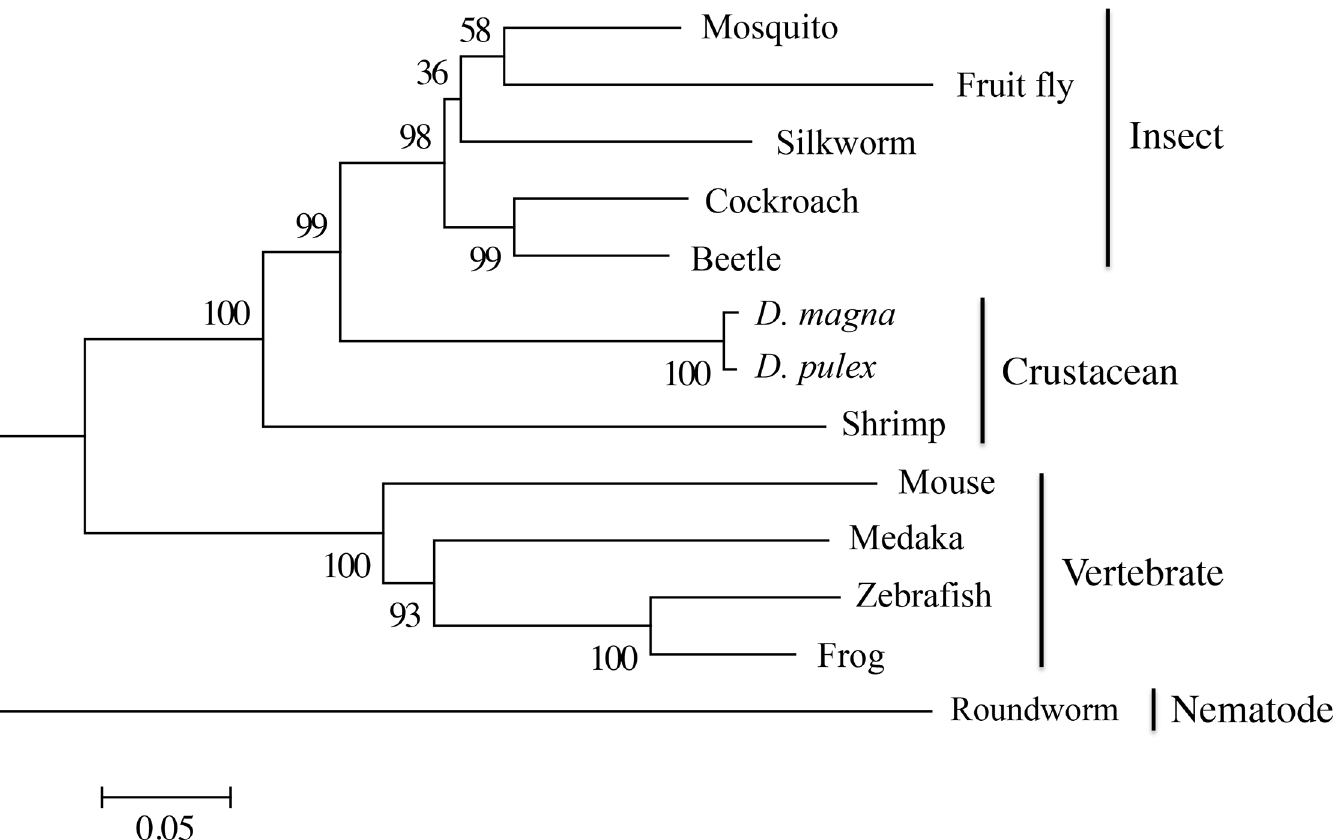
Fig 3. Phylogenetic tree of the amino acid sequences of the DBD and LBD Ftz-F1 nuclear hormone receptor subfamily. The percentages of the replicate tree in which the associated taxa clustered together in the bootstrap test (1,000 replicates) are shown next to the branches. The bar indicates branch length and corresponds to the mean number of the differences ( P < 0 . 05 ) per residue along each branch. Evolutionary distances were computed using the p-distance method.